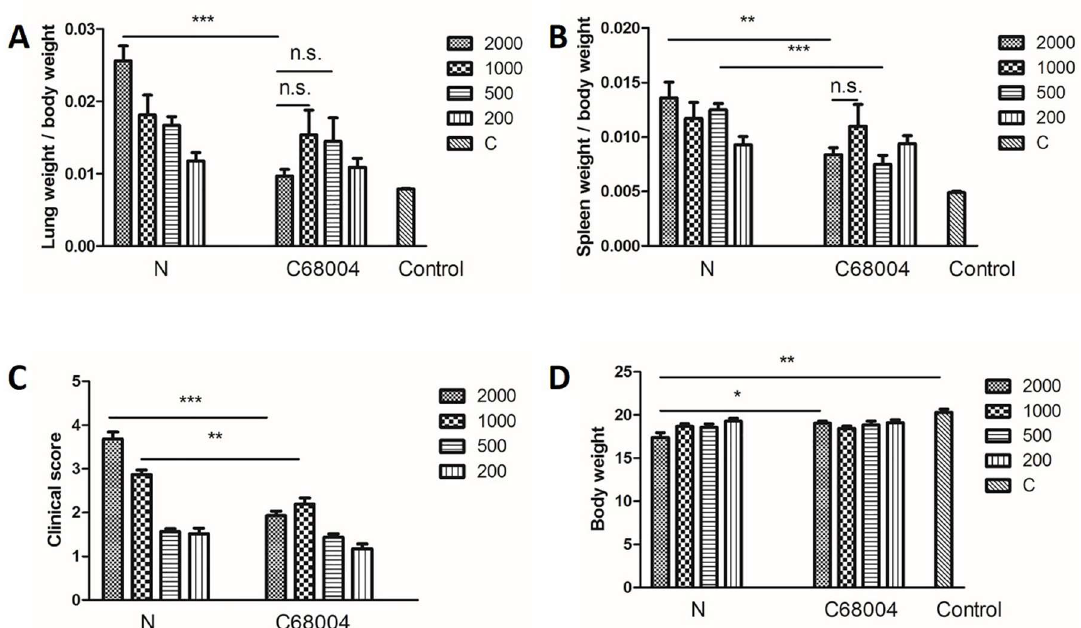
Figure 3. Organ coefficient of the lung ( A ) and spleen ( B ), score of clinical symptoms ( C ) and body weight ( D ) from mice infected with different CFU of M. bovis N and M. bovis C68004 strains or PBS 30 days post-inoculation. The experiment was repeated two times independently. Statistical analysis was performed using student’s unpaired t -test (two-tailed). Bars represent means SEM ( n = 6); * p < 0.05, ** p < 0.01; *** p < 0.001.